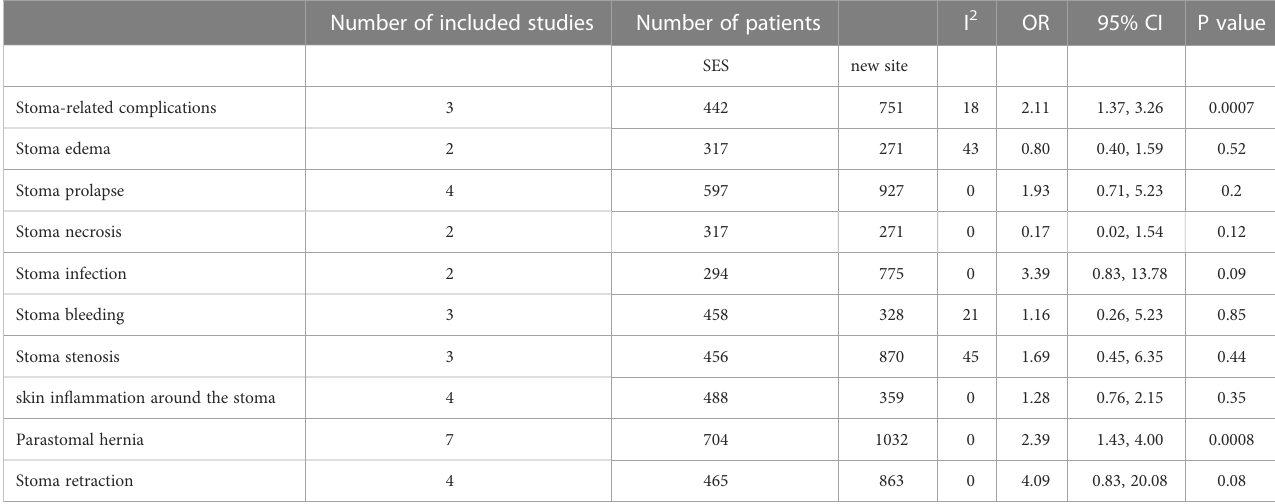
TABLE 3 The results of the pooled analysis of stoma-related